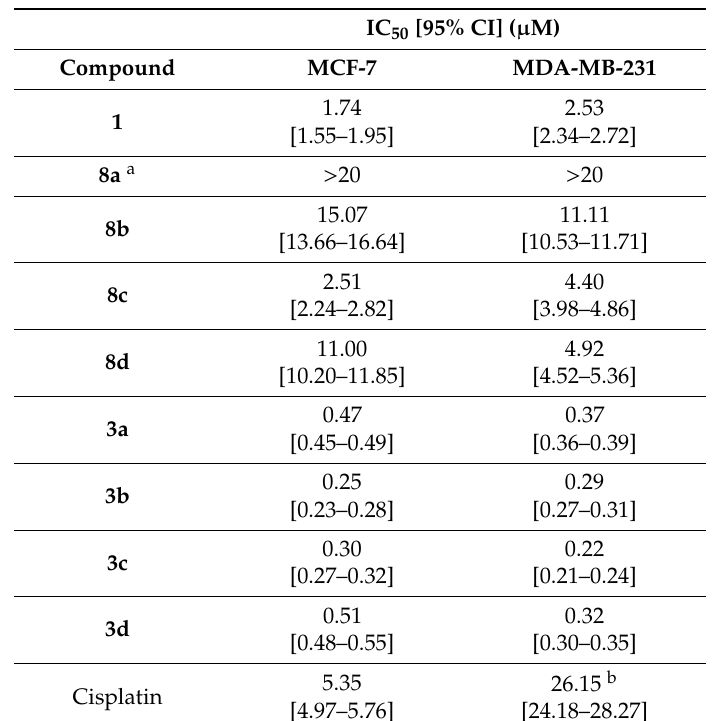
Table 1. Cytotoxic activity of hybrid compounds 3a – d and their corresponding fragments 1 and 8a – d on human breast cancer cell lines. Confidence interval: 95% CI, n = 6 from two biological replicates ( n = 3 each). Positive control: cisplatin, n = 10 from two biological replicates ( n = 5